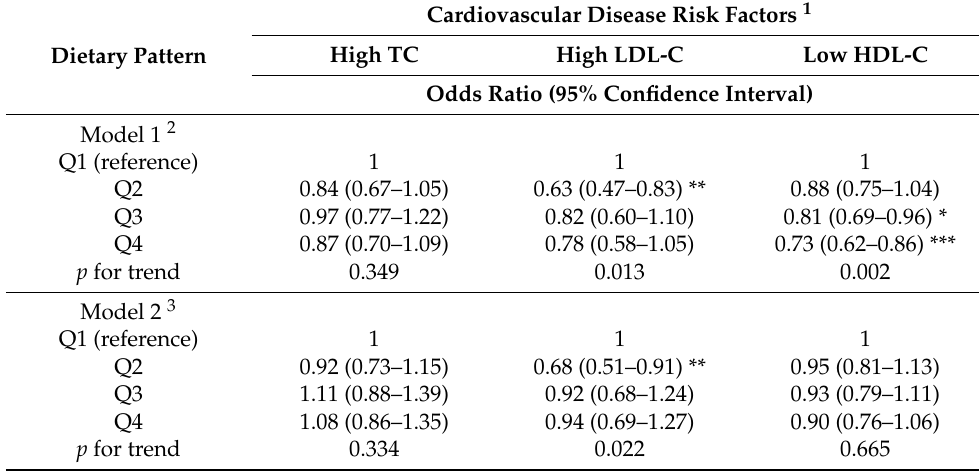
Table 4. Binary logistic regression for the association between the dietary pattern, total cholesterol (TC), low-density lipoprotein cholesterol (LDL-C), and high-density lipoprotein cholesterol (HDL-C) ( n =